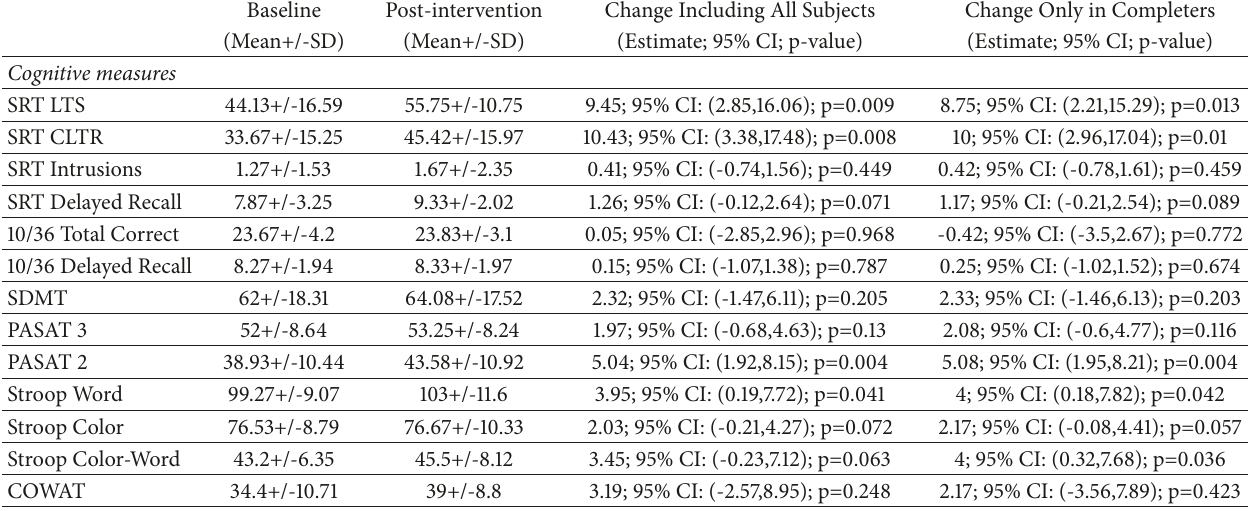
Table 2: Summary statistics for cognitive